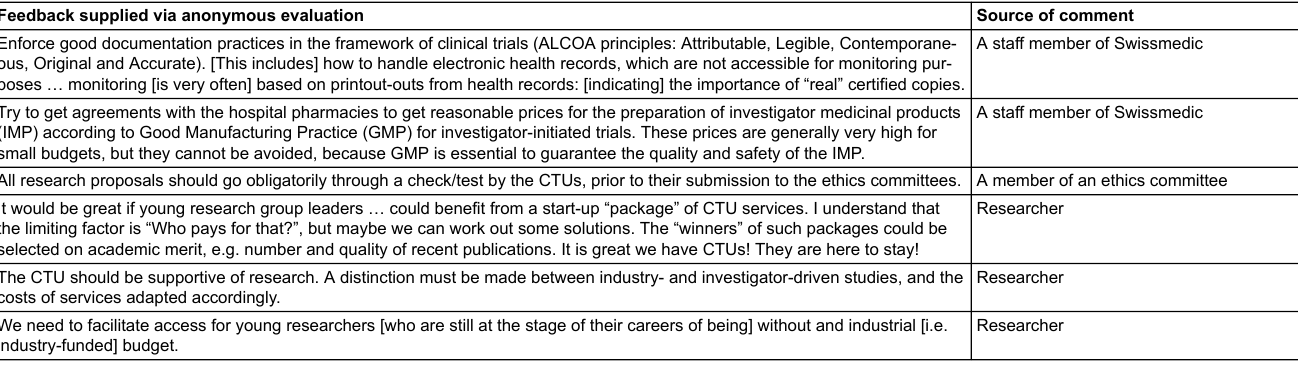
Table 1: A selection of suggestions on improving CTUs, from anonymous